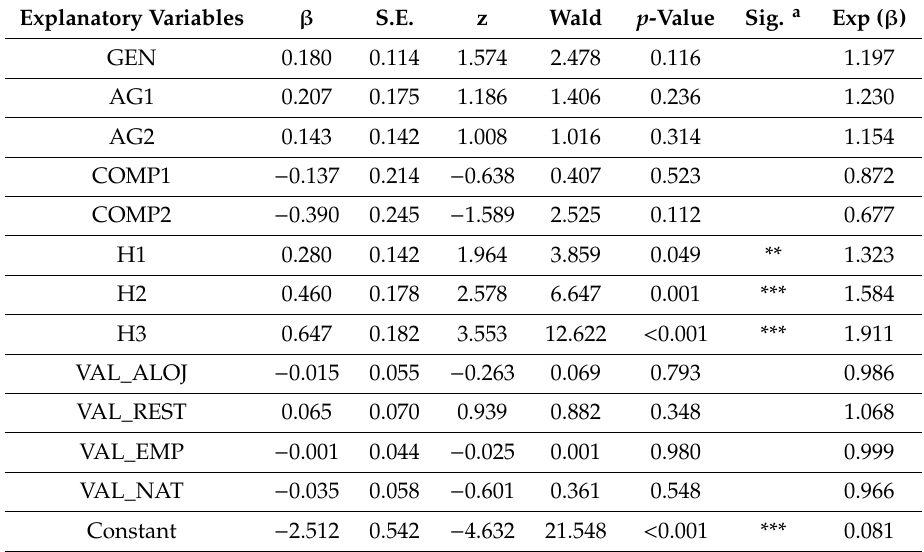
Table 3. Estimation of the binary logistic regression model (1) for national tourists. Explanatory Variables